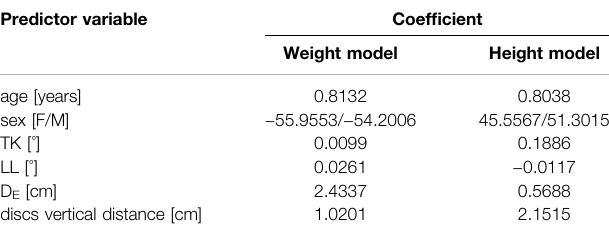
TABLE A2 | Estimated coef fi cients of the linear regression models for the prediction of weight and height. Predictor